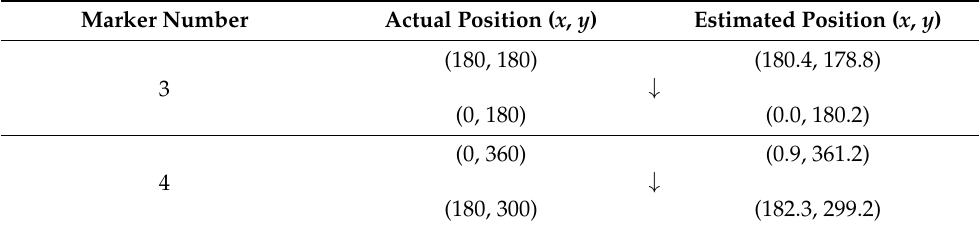
Table 5. Position of the moved marker.